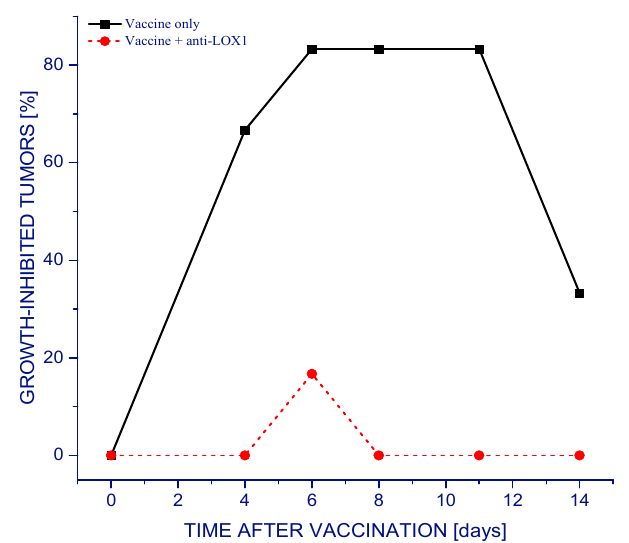
Figure 1. The effect of blocking LOX-1 receptor on the therapeutic efficiency of PDT-generated vaccines. Mice bearing SCCVII tumors received a peritumoral injection of a vaccine consisting of SCCVII cells treated in vitro by PDT and processed as described in Materials and Methods. LOX-1 neutralizing antibodies were injected into mice (30 µ g/mouse i.p.) 30 min before vaccine administration. The response to therapy was assessed by tumor size measurement, and is presented as the percentage of growth-inhibited tumors (smaller than the means minus two-fold standard deviation of unvaccinated control group). The response to the PDT vaccine plus anti-LOX1 (circles) is statistically different from vaccine only (squares) group ( p < 0.05; n = 6).